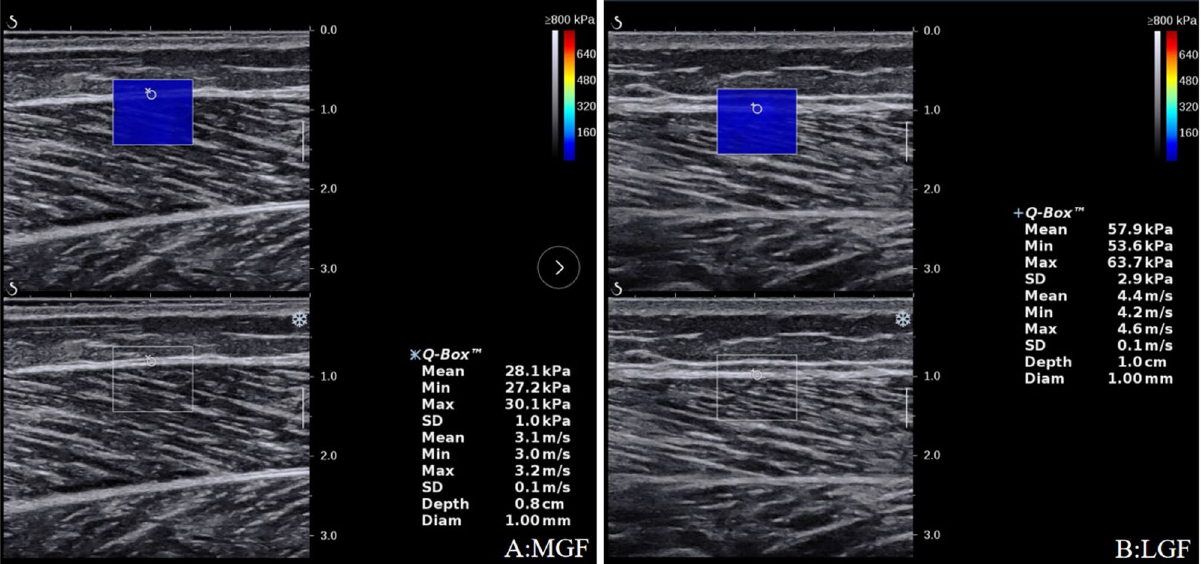
Figure 1. Typical maps of the elastic properties of the MGF and LGF in the longitudinal directions. Color- coded boxes representing muscle fascia elasticity are shown in the upper images. The longitudinal grayscale sonograms of muscle fascia are shown in the bottom images. The measurement of shear modulus is performed in a circle. The Q-Box™ is shown on the right. MGF: medial gastrocnemius fascia; LGF ( B ): lateral gastrocnemius